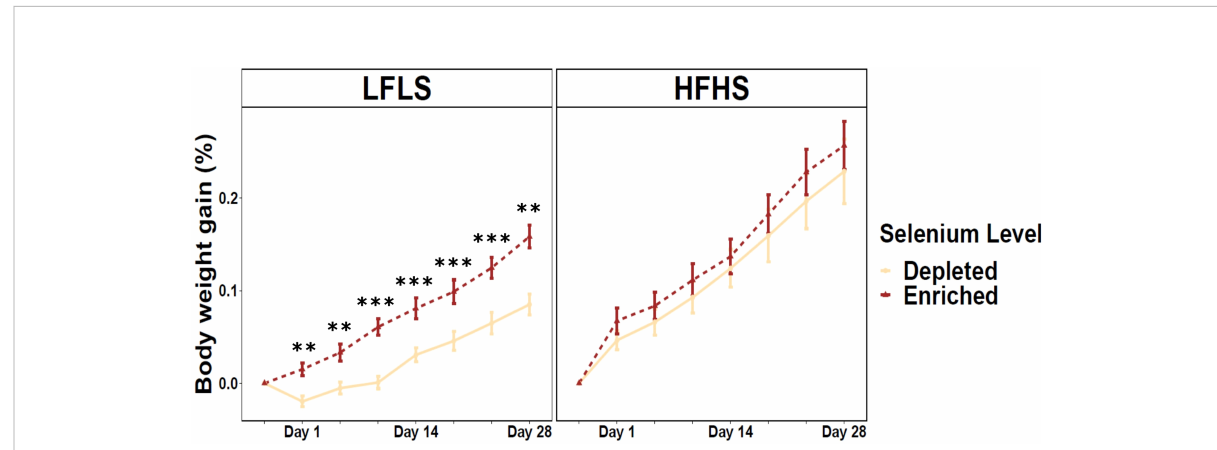
FIGURE 1 Weight gain in mice fed Se-enriched and Se-depleted LFLS or HFHS diets. Groups of 12 mice (6F/6M) were fed Se-enriched and/or Se-depleted diets combined with LFLS or HFHS diet for 28 days. Generalized linear regression models were used to identify the effects of time or Se and interactions. Data are expressed as mean ± SEM (n = 12). P values of linear contrast analysis are identi fi ed when signi fi cant ‘ *** ’ P < 0.001, ‘ ** ’ , P < 0.01, using contrast between enriched and depleted Se levels, LFLS and HFHS formulations and the combination between Se levels and